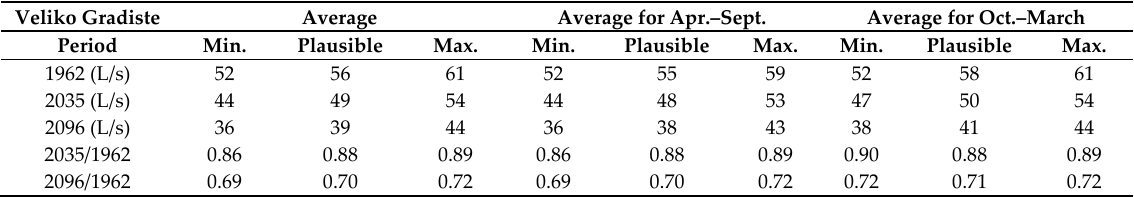
Table 3. Water availability based on average monthly hydrology—worst year of the period, at Jelak. Veliko Gradiste Average Average for Apr.–Sept. Min. Plausible Max. Min. Min. Max.